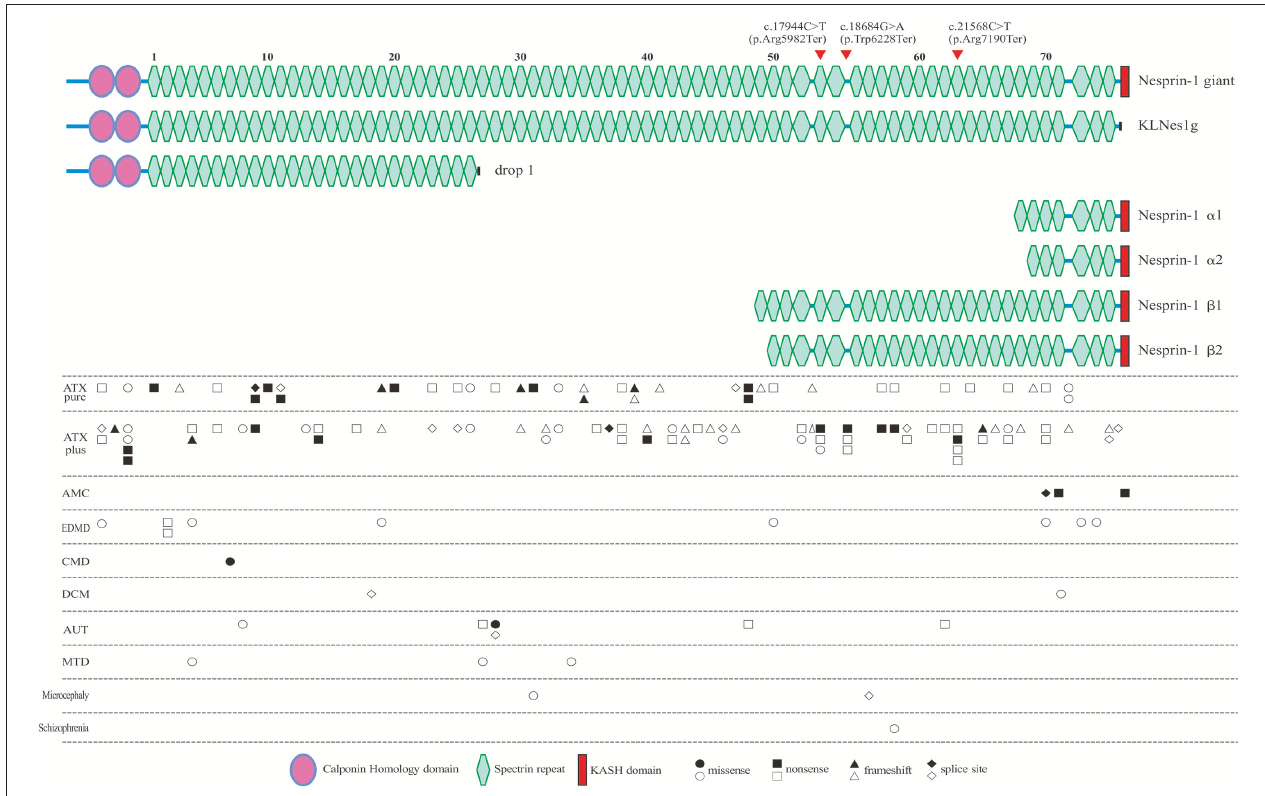
FIGURE 4 | All of the reported pathogenic SYNE1 variants, and their locations in the schematic diagram of Nesprin-1 and some of the major alternating isoforms of SYNE1 . Locations of the variants found in the present study are denoted by the arrow head. Circle variants are missense variants, rectangles are non-sense variants, triangles are frameshift variants, and rhombus are splice site variants. Biallelic variants are shown in a solid color. ATX pure, patients with pure ataxia; ATX plus, ataxia patients with some other non-ataxia symptoms; AMC, arthrogryposis multiplex congenital; EDMD, Emery-Dreifuss muscular dystrophy; CMD, congenital muscular dystrophy; DCM, dilated cardiomyopathy; AUT, autism; MTD, mental retardation as the major